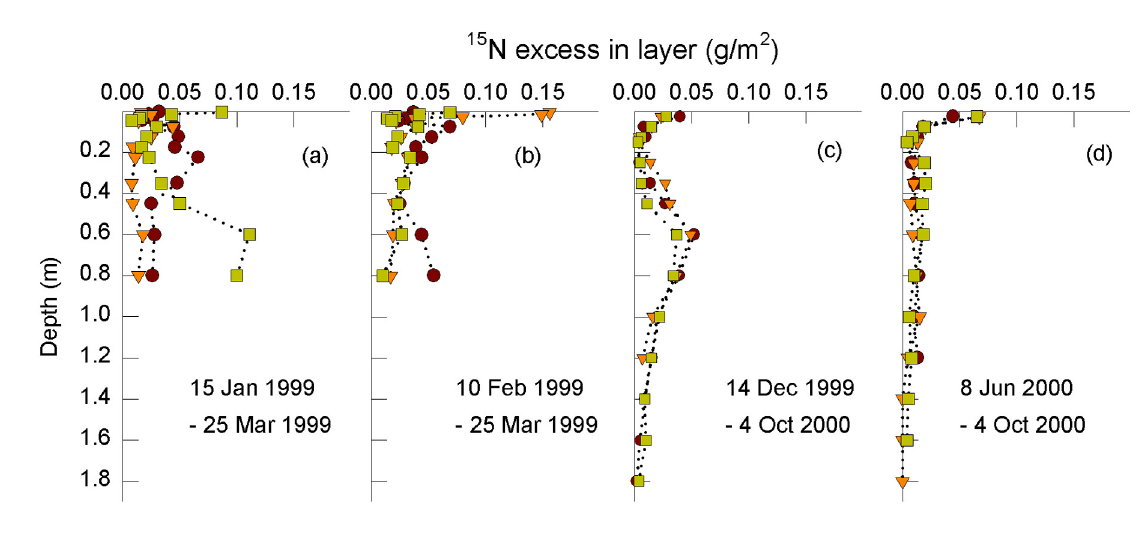
FIGURE 4. Distribution of 15 N in the soil profile of the three subplots at harvest of the 1998/99 maize crop (a, b) and at harvest of the 2000 oat crop (c, d). 15 N labelled (NH ) SO and Br were applied on (a) January 15, 1999, (b) February 10, 1999, (c) December 14, 1999 and (d) June 8, 2000. The site was irrigated from 4 2 4 December to March with treated piggery effluent (Table